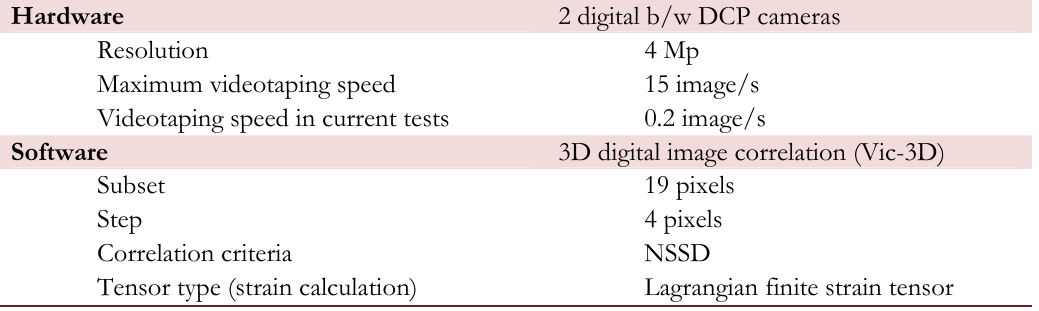
Table 1: Technical parameters of strain field